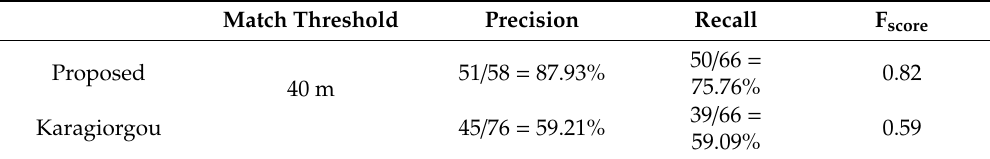
Table 5. Comparison of road intersection detection.